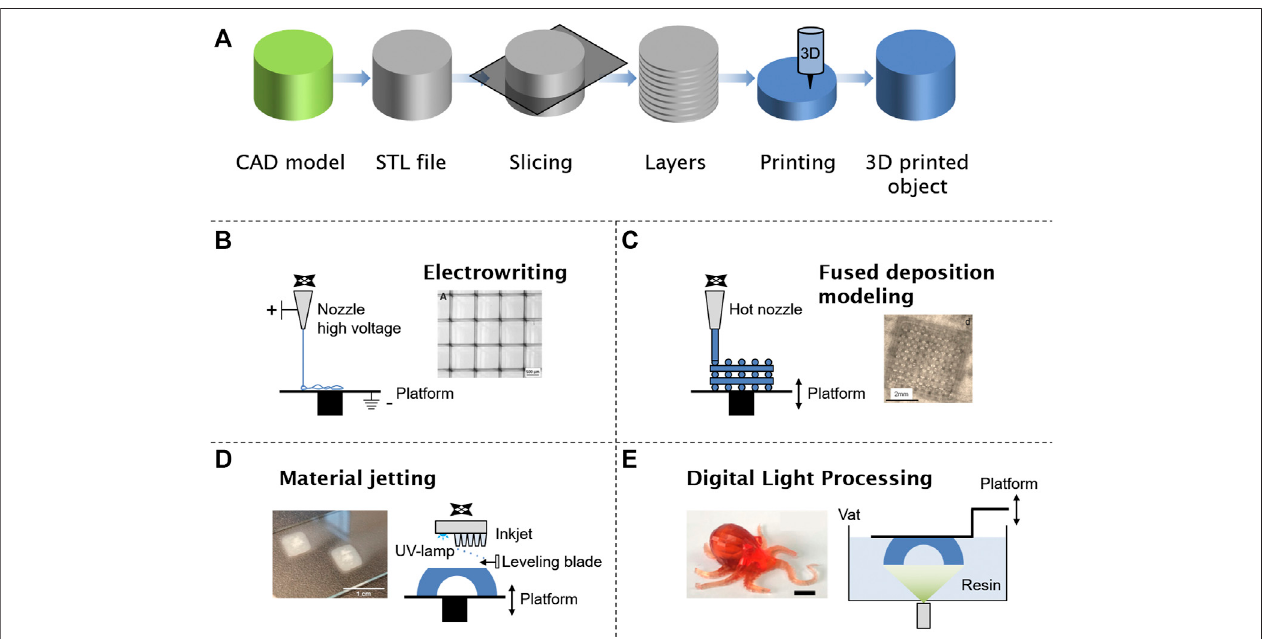
FIGURE1| General stepsforany 3D-printingtechnologystarting withadigital model. The fi le isconverted inanof fi cialadditivemanufacturing fi le format (STL)and sliced into several layers of some micrometers. The 3D-printing setup will print in a layer-by-layer process to obtain a 3D object (A) . Manufacturing of supramolecular polymers by electrospinning (B) , fused deposition modeling (C) , material jetting (D) , and digital light processing (E) . Adapted with permission (Hart et al., 2016; Hochleitner et al., 2018; Rupp et al., 2019; Zhu et al., 2021). Copyright 2018, John Wiley and Sons. Copyright 2019, John Wiley and Sons. Copyright 2016, American Chemical Society. Copyright 2021, American Chemical